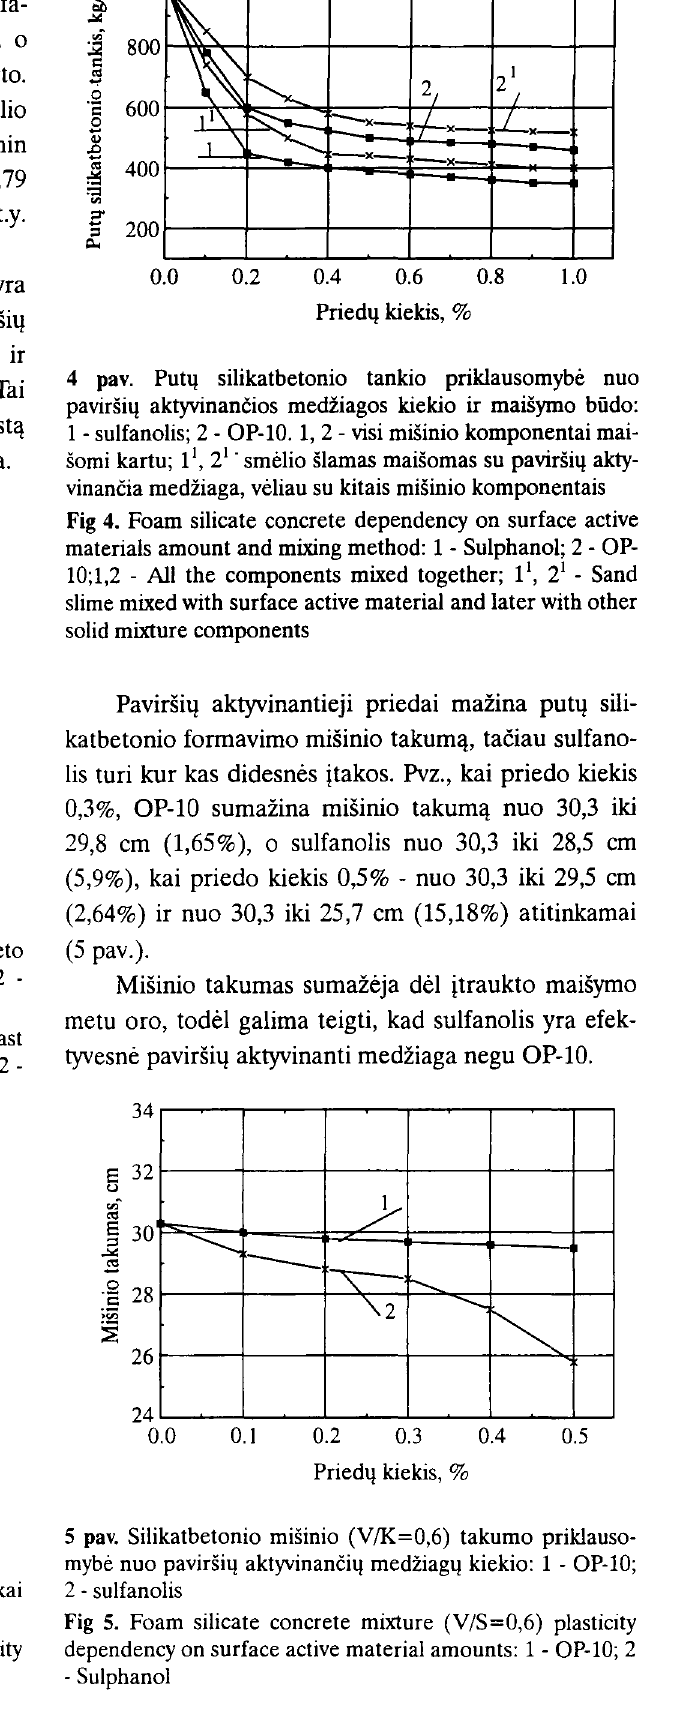
Fig 3. The influence of mixing time on sand slime density with surface active materials: 1- OP-10; 2- Sulphanol